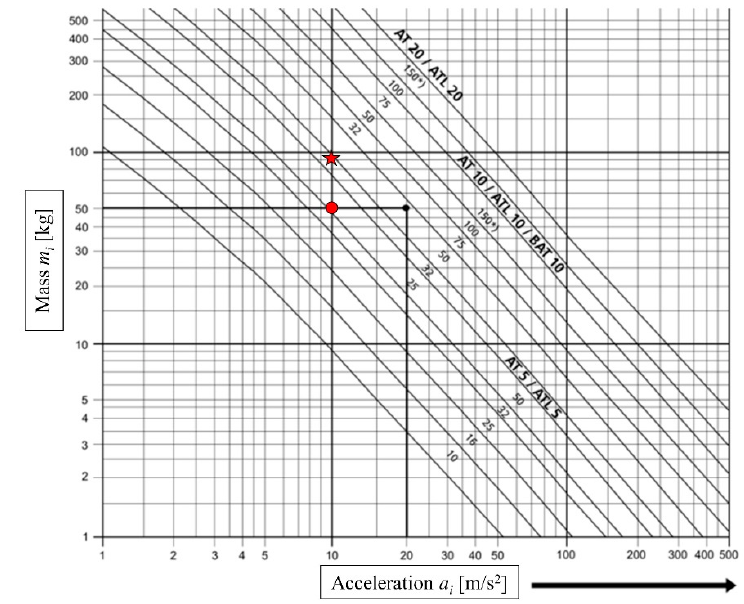
Figure 5. Methodology of the selection of the toothed belt on the basis of the manufacturer’s catalog data [28]: red dot and star represents the combination of mass and acceleration for WDUD and PDD respectively.